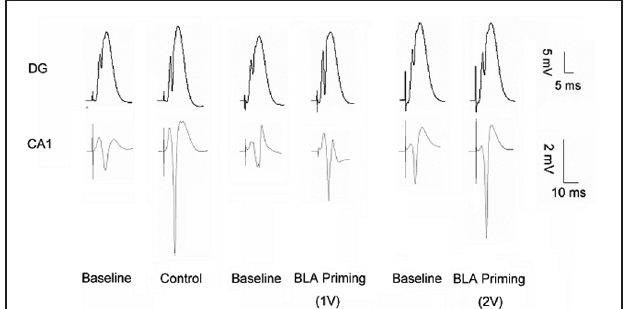
FIGURE 4 | Representative analog traces recorded during baseline and during 51–60min post the moderate theta burst stimulation from an individual of the Control and BLA priming